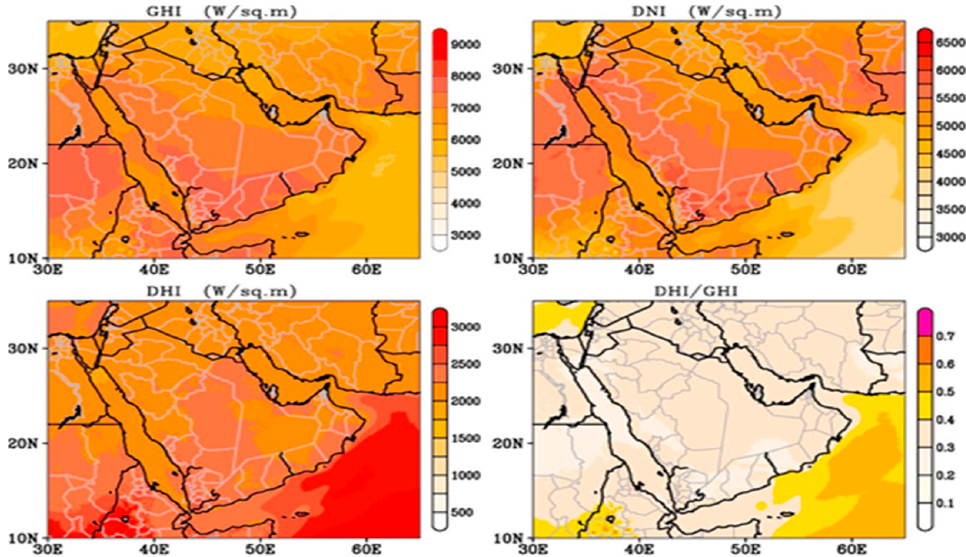
Figure 2. The annual mean of global horizontal irradiance (GHI), direct normal irradiance (DNI), and diffuse horizontal irradiance (DHI) in W/m 2 and the performance of the diffuse fraction (DHI/GHI) over 37 years (1980–2017) in the GCC region. Copyright © 2021 Elsevier [55].